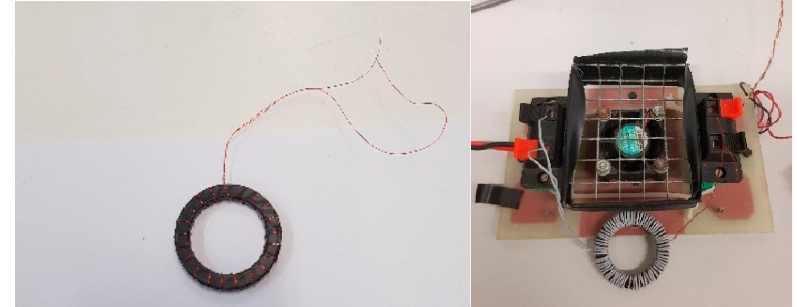
Figure 5. Toroid sample preparation for the test: winding process and test setup.